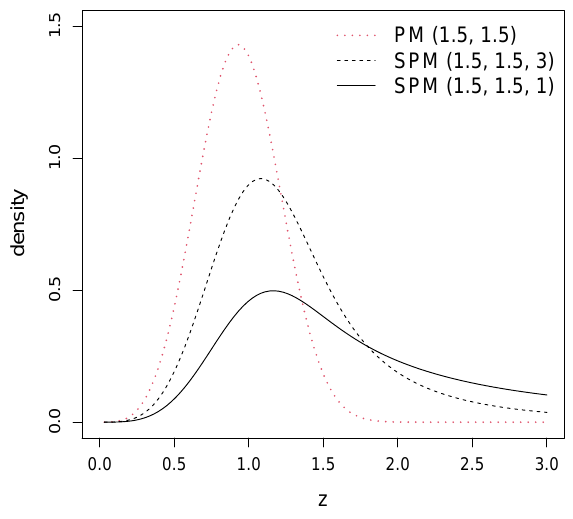
Figure 1. Plots of the power Maxwell (PM) and slash power Maxwell (SPM)